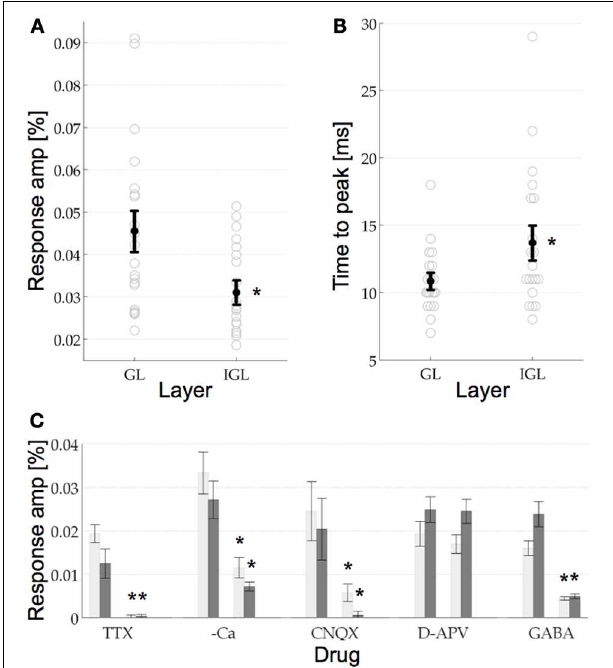
FIGURE 3 | (A) VSDI response amplitude in the GL and the IGL. The response amplitude in the GL was 0.0456%, which was significantly higher than in the IGL at 0.0311%. Error bars are the s.e.m, circles are the raw data, n = 20. (B) Response time to peak for the two layers. Same format as (A) . The response in the GL reached its maximal response amplitude after 13.85ms, which was significantly earlier than the response in the IGL at 16.7ms. (C) Pharmacological manipulations in the two layers. T -tests revealed that the signal in the GL (light gray bars) and the IGL (dark gray bars) was reduced significantly by TTX, Calcium free aCSF (–Ca), CNQX, and GABA. Neither layer showed any significant response to D-APV. See Results for details, error bars are the